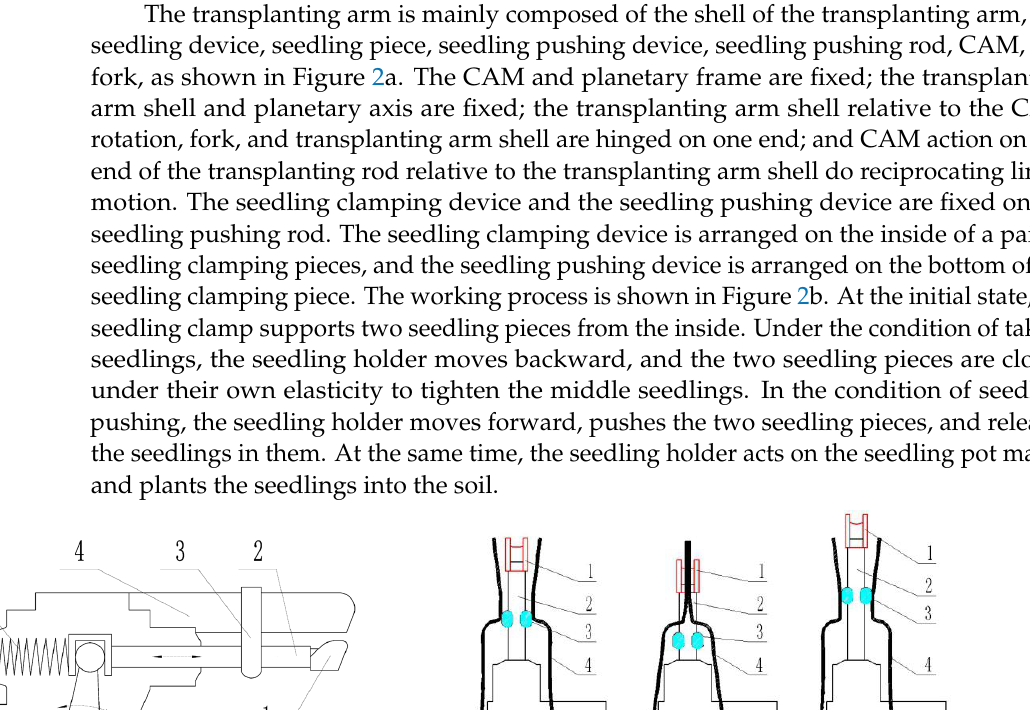
Figure 1. Schematic diagram of rice bowl seedling transplanting mechanism. 1, planetary gear I; 2, intermediate gear I; 3, solar gear; 4, intermediate gear II; 5, planetary gear II;6, planetary carrier; 7, transplanting arm I; 8, transplanting arm II; 9, transplant trajectory.